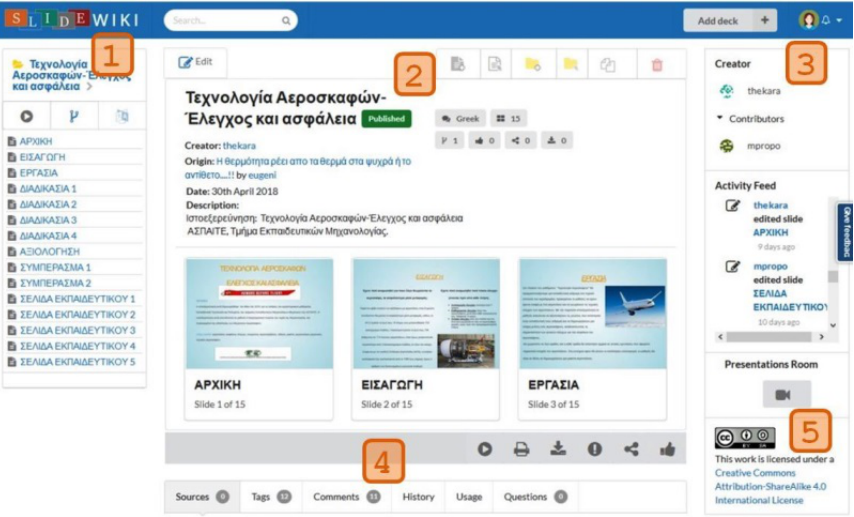
Fig. 1. A SlideWiki deck developed during our study (usernames